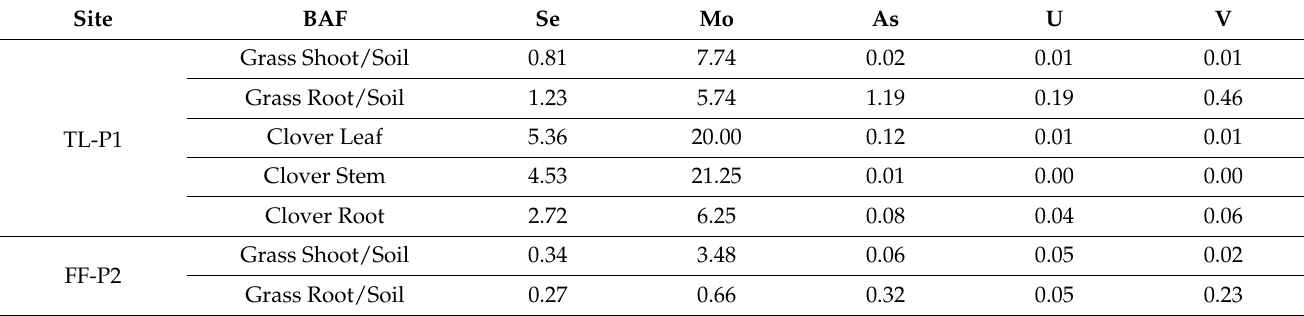
Table 8. Bioaccumulation factors (BAF) calculated for sites TL-P1 and FF-P2 (0–10